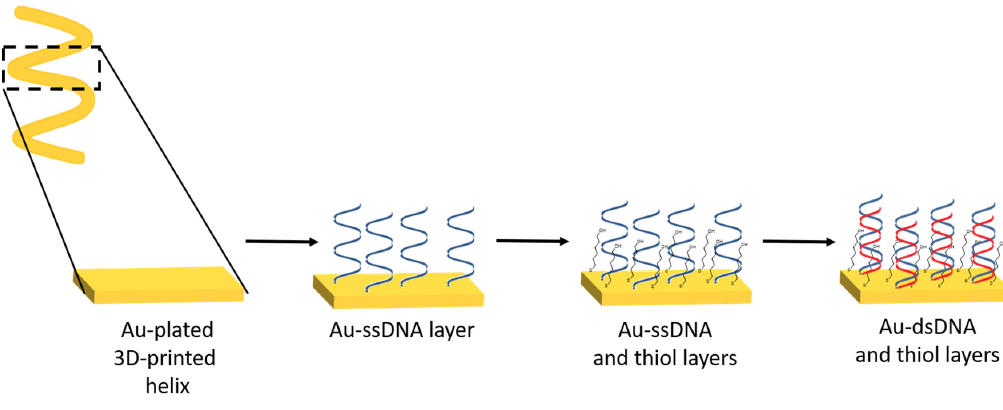
Figure 3. Schematic representation of the preparation of DNA biosensor. The thiolated DNA was covalently immobilized onto a gold-plated 3D-printed helix electrode. The modified electrode was then incubated with a DNA target, and the electrode was then exposed to methylene blue. Adapted from [114] . 3D-printed metal electrodes are expensive and offer a limited electrochemical potential window